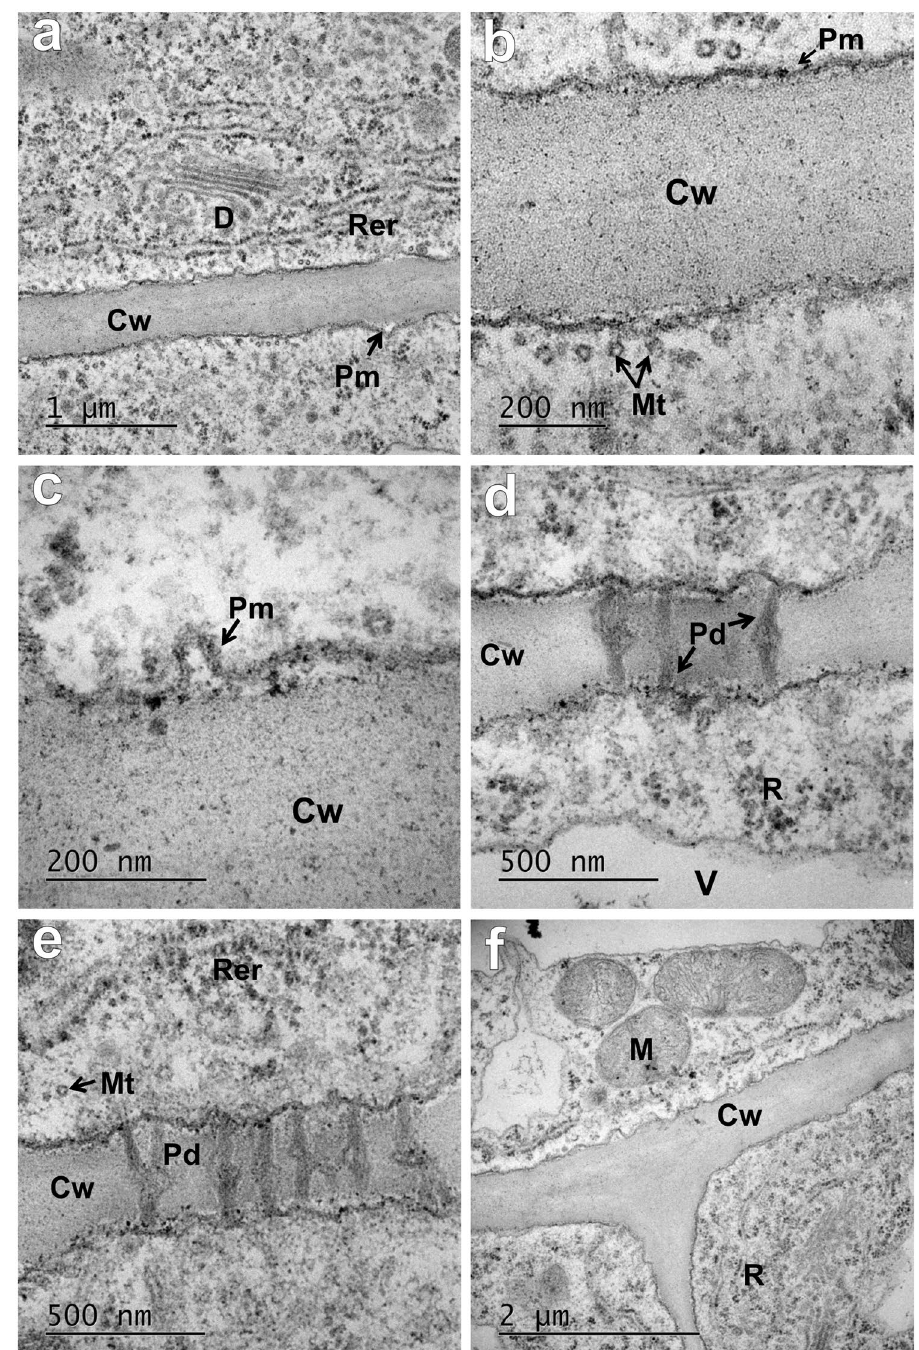
Figure 2. Representative ultrastructure of the cells of barley seedling roots grown in a 5 nm AuNPs hydroponic solution. ( a–e ) Parenchyma cells; ( f ) Vascular tissue; ( a–c ) Concentration of 10 µ g/ml of AuNPs in the medium; ( d–f ) Concentration of 50 µ g/ml of AuNPs in the medium; ( a–f ) Gold nanoparticles were not present in any of the cell organelles regardless of the type of tissue. It was confirmed that the electron-dense dots, which were considered to be nanoparticles at first, were not AuNPs as they did not show the crystal structure of an Au (staining with osmium tetraoxide, lead citrate and uranyl acetate). Cw – cell wall; D – dictyosome; M – mitochondrion; Mt – microtubule; Pd – plasmodesmata; Pm – plasmalemma; R – ribosome; Rer – rough endoplasmic reticulum; V –